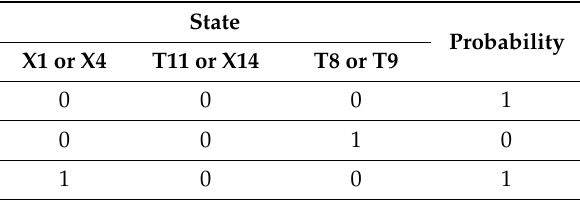
Table A1. CPT for T8 and